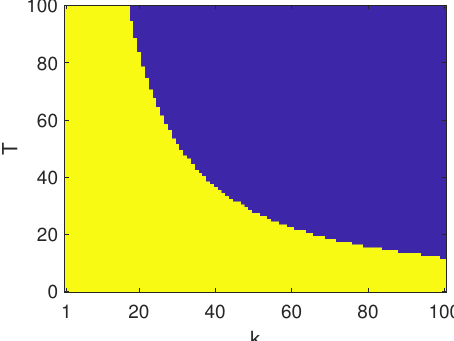
Figure 11. The boundary in the parameter space k − T between the stability (yellow) and instability (blue) regions, for z = 1. Other parameters are as reported in the caption of Figure